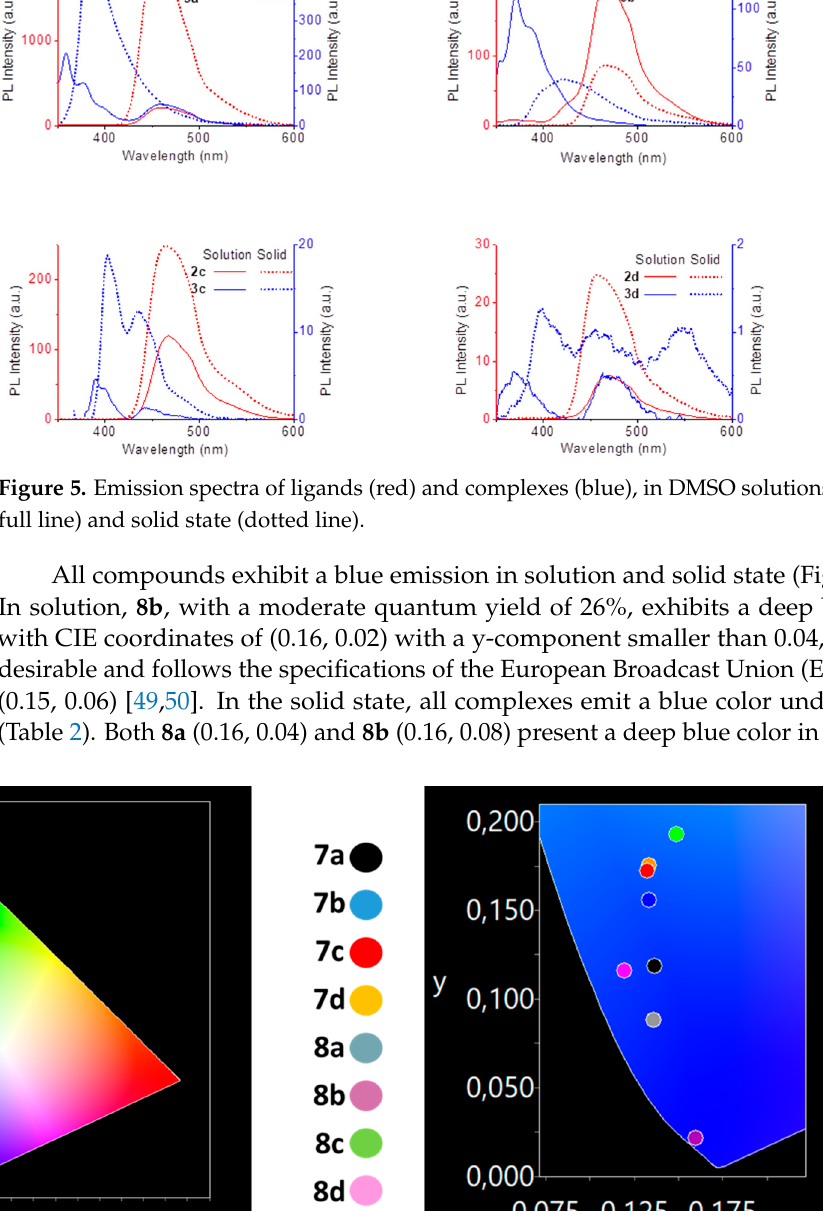
8 of 12 Figure 4. ESIPT fluorescence of benzimidazol derivatives.